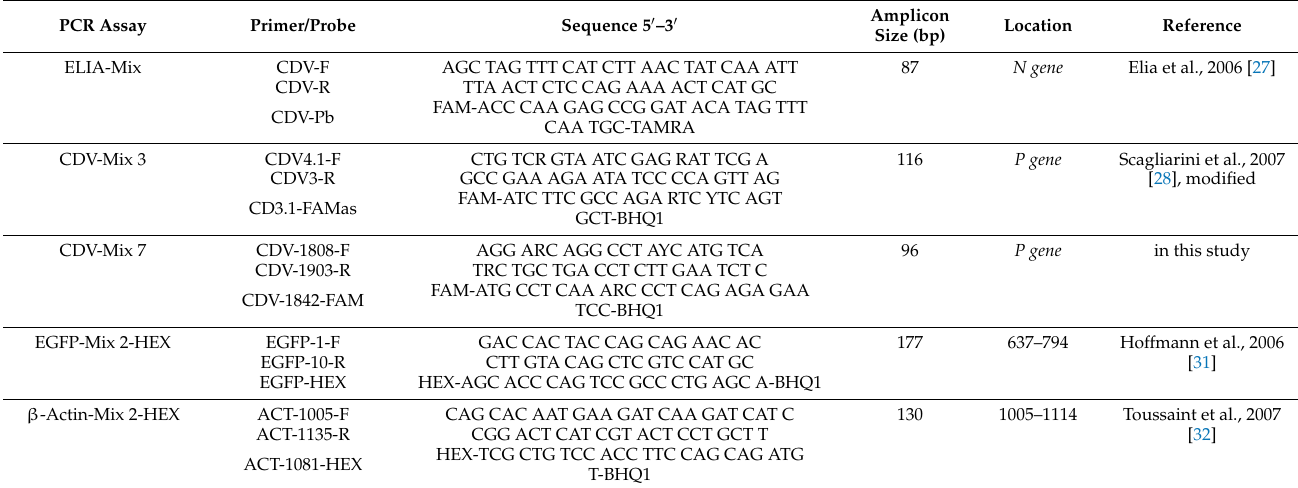
Table 1. Sequences of finally used primers and